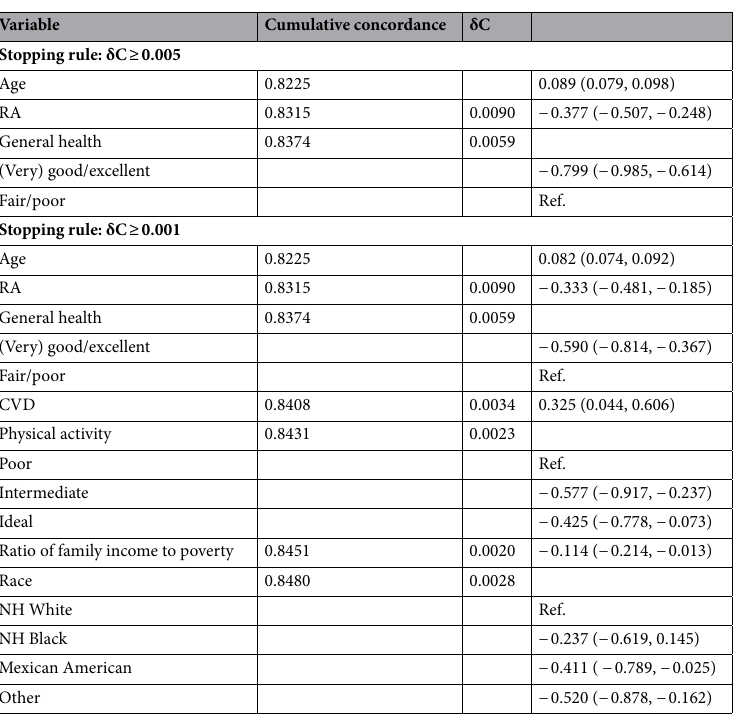
Table 3. Results of forward selection using a set of predictor variables based on improvement in concordance (δC). RA Relative amplitude; NH Non-Hispanic. Variables were listed in order of their inclusion into the model and the tenfold cross-validated concordance from a model which included all variables up to the current variable that was presented in the second column. The fourth column presented the estimated coefficient and 95% CIs obtained from the final models fit for each stopping rule. RA has been divided into quartiles.